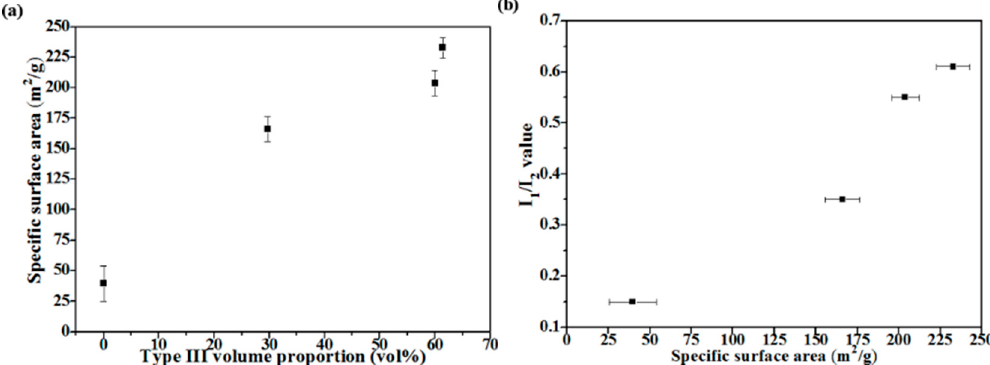
Figure 8. ( a ) Correlations between specific surface area and Type III particles and ( b ) bioactivity and specific surface area of all BG powders.